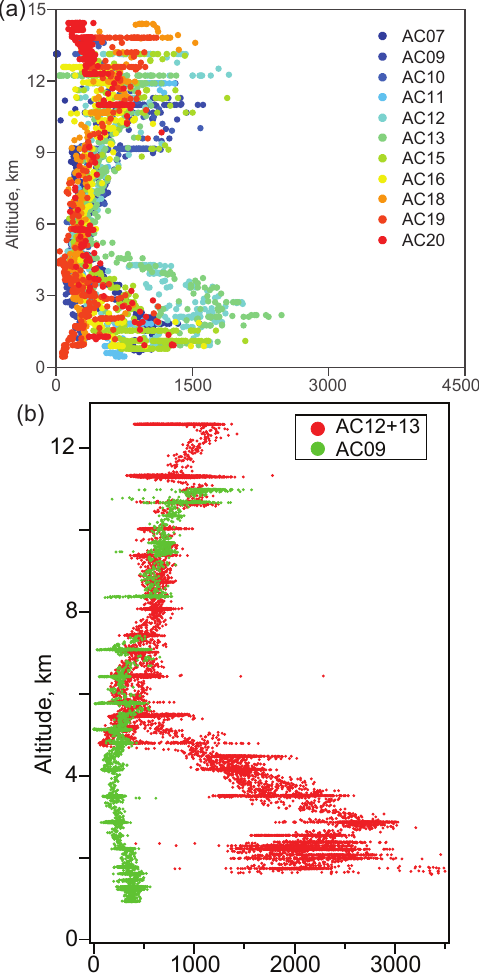
Figure 11. Vertical profiles of CCN concentrations at 0.52% su- persaturation; (a) overall statistics from all flights (1min averages), (b) examples from individual profiles on flights AC09 (green) and AC12 + 13 (red). Flights AC12 and AC13 were conducted over the same region on successive